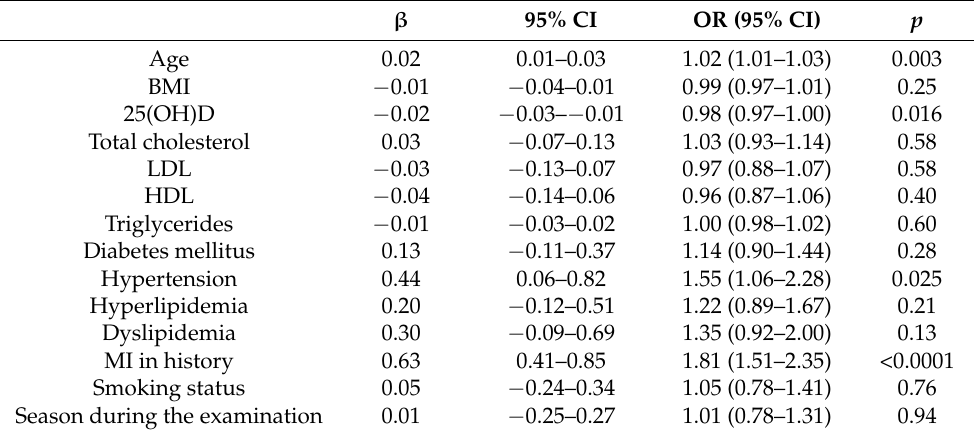
Table 2. Determinants of CASS